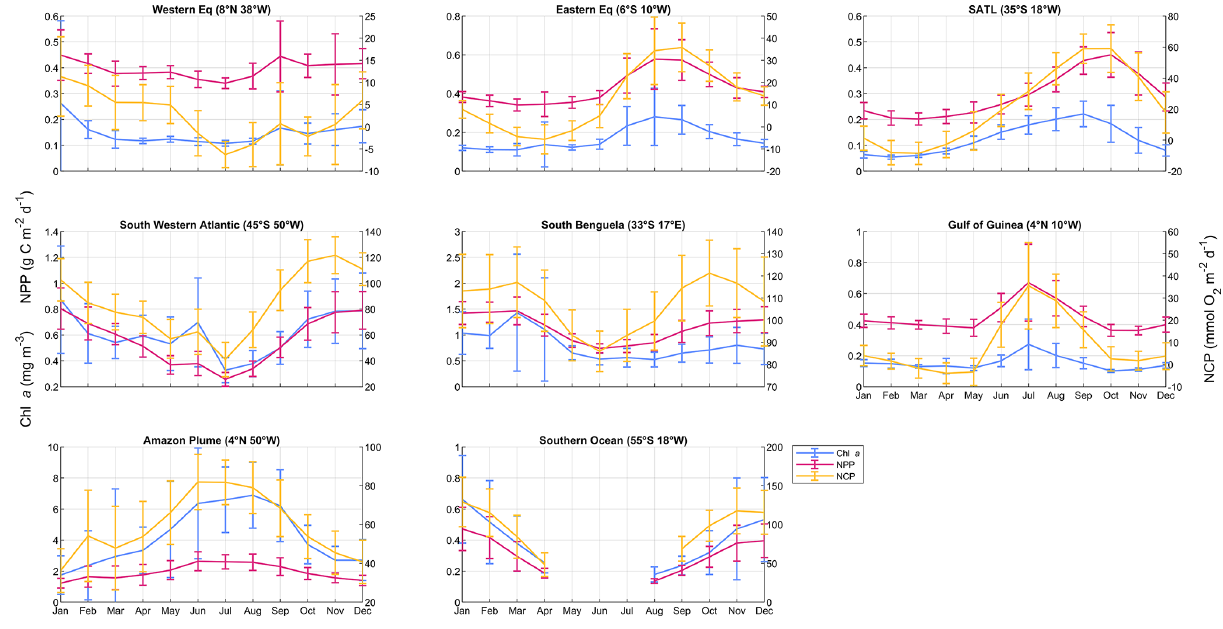
Figure C1. Monthly climatologies of the biological parameters (Chl a , NPP and NCP) for the eight stations (Fig. 1a). Chl a and NPP scale on the left axis, and NCP on the right. Note the different axis limits on each